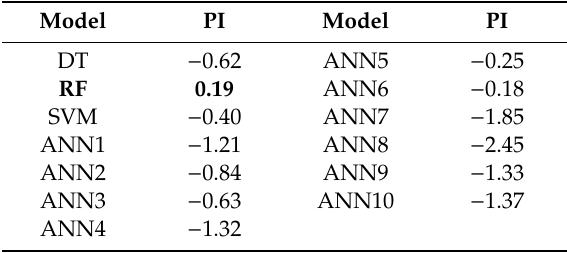
Table 4. Persistence index computed on machine learning models.